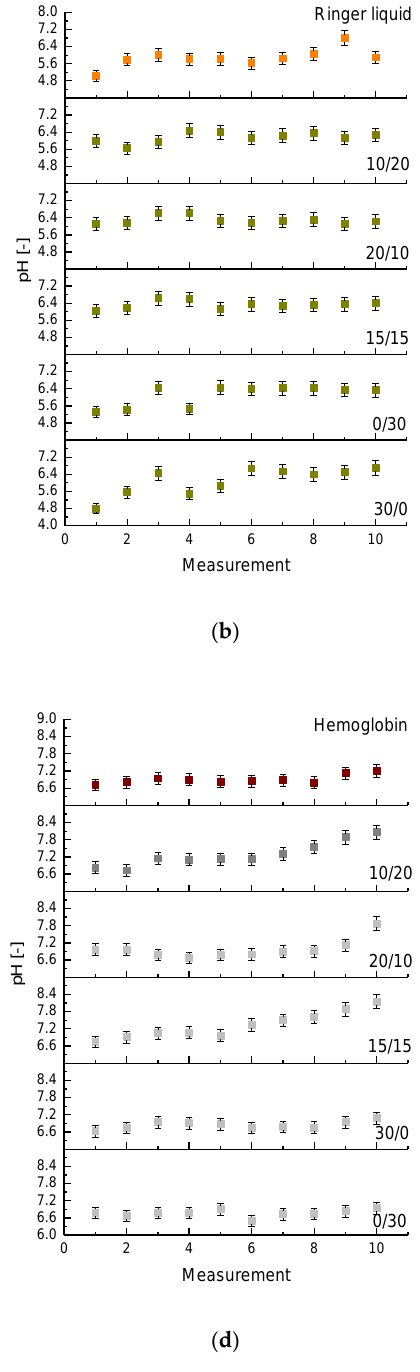
Figure 4. Results of incubation studies in distilled water ( a ), Ringer liquid ( b ), SBF ( c ) and hemoglobin ( d ). Analyzing above-presented results, it may be observed that in the case of all im- mersed samples pH values of liquids measured during the incubation were only slightly different. The buffering properties of the analyzed hydrogels were most visible in the SBF solution thus such an environment seemed to be the most adequate for further studies on the developed matrices in terms of their use for biomedical purposes. Performed incubation investigations allowed to indicate that the most promising re- sults were observed for sample 20/10 (obtained using 20 mL of chitosan solution and 10